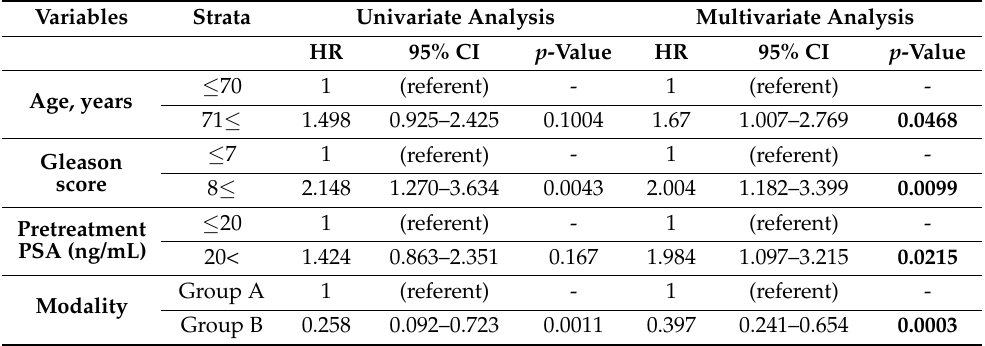
Figure 3. Biochemical disease-free rate (bDFS), prostate cancer specific survival rate (PSS), and overall survival rate (OS) among conventional external beam radiotherapy (Conv EBRT), high dose external beam radiotherapy (HDEBRT), and high dose rate brachytherapy (HDR) boost groups; ( a ) biochemical control rates; ( b ) prostate cancer specific survival rate; and ( c ) overall survival rate. Table 3. Univariate and multivariate analysis for biochemical control rate using Cox proportional hazards model. Variables